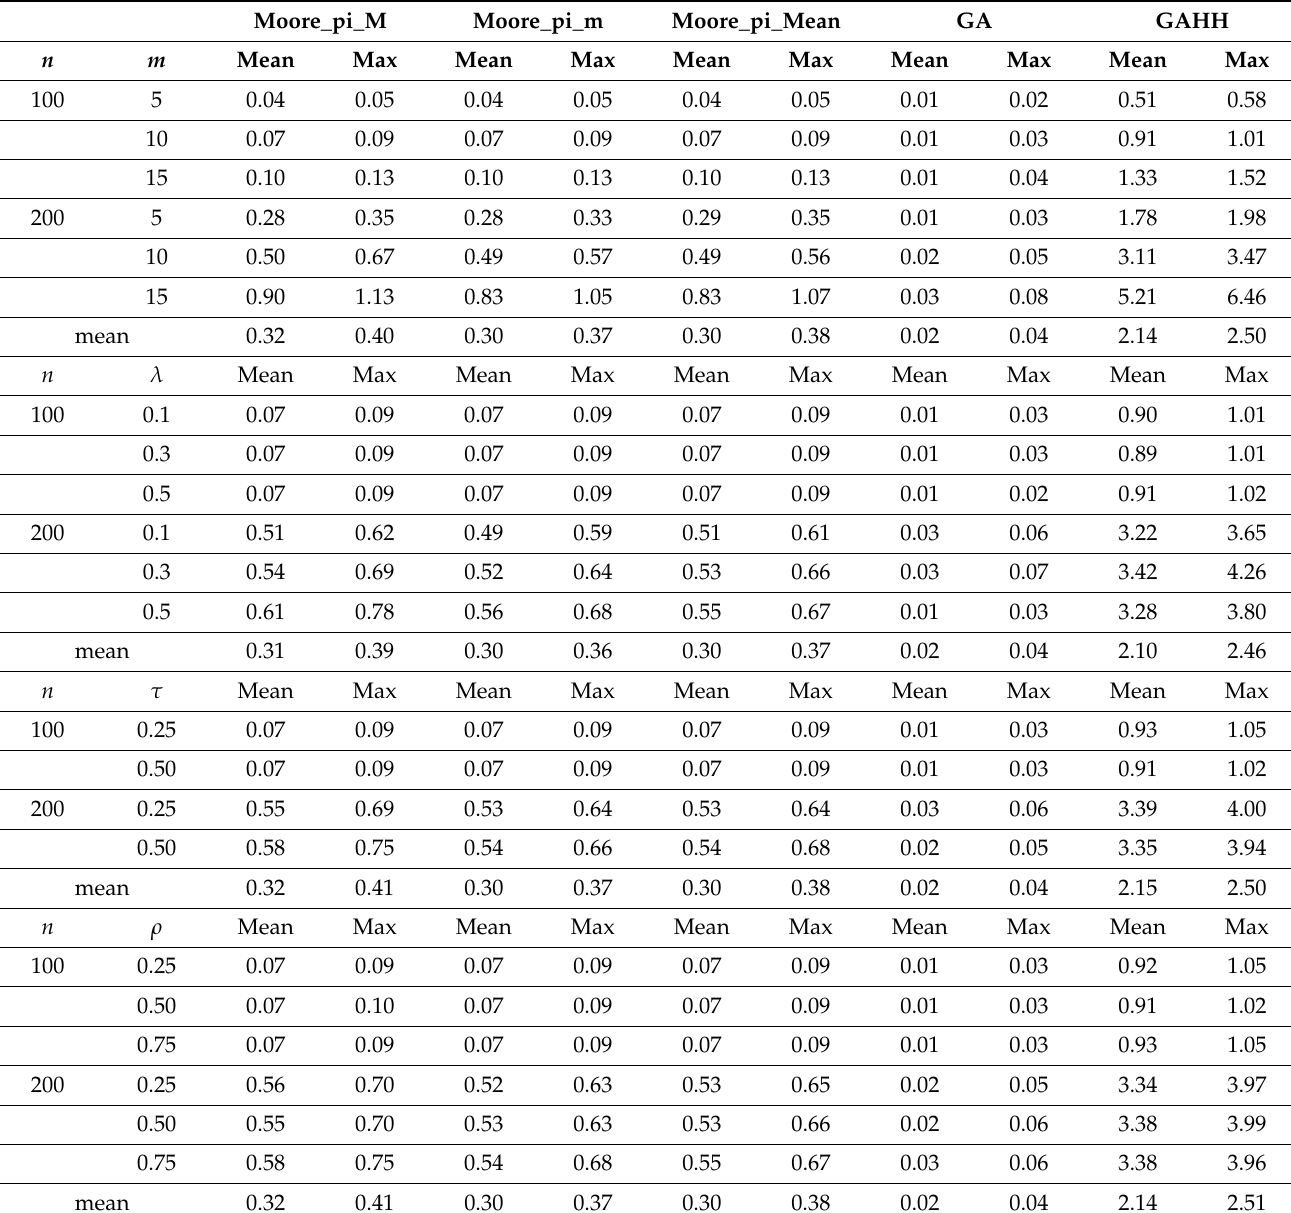
Table 5. CPU times obtained with proposed heuristics and algorithms for large n